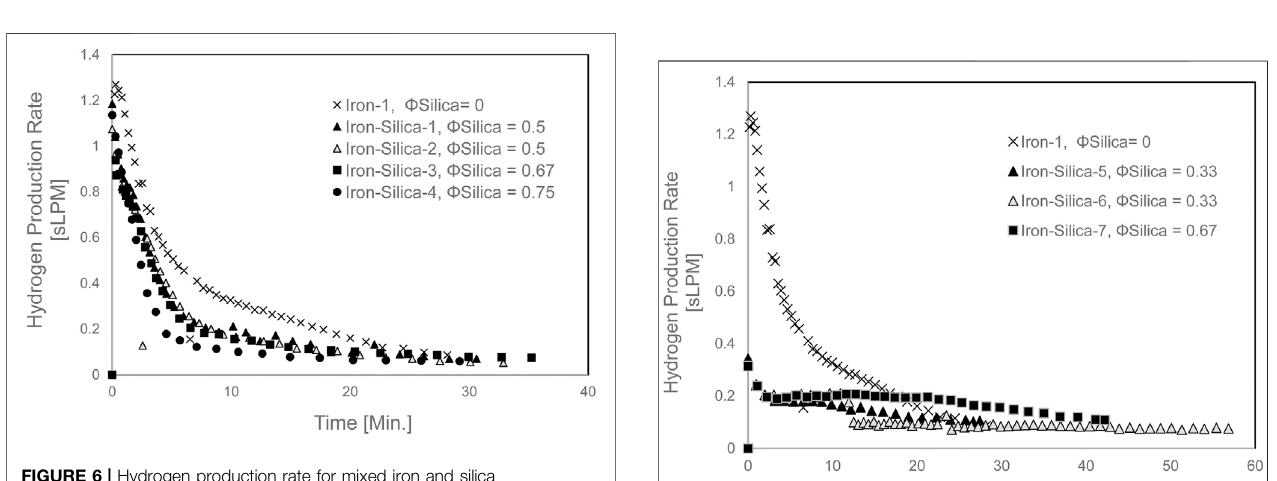
FIGURE 6 | Hydrogen production rate for mixed iron and silica (200 – 300 µm) with various silica volume fractions at 650 ° C set furnace temperature).